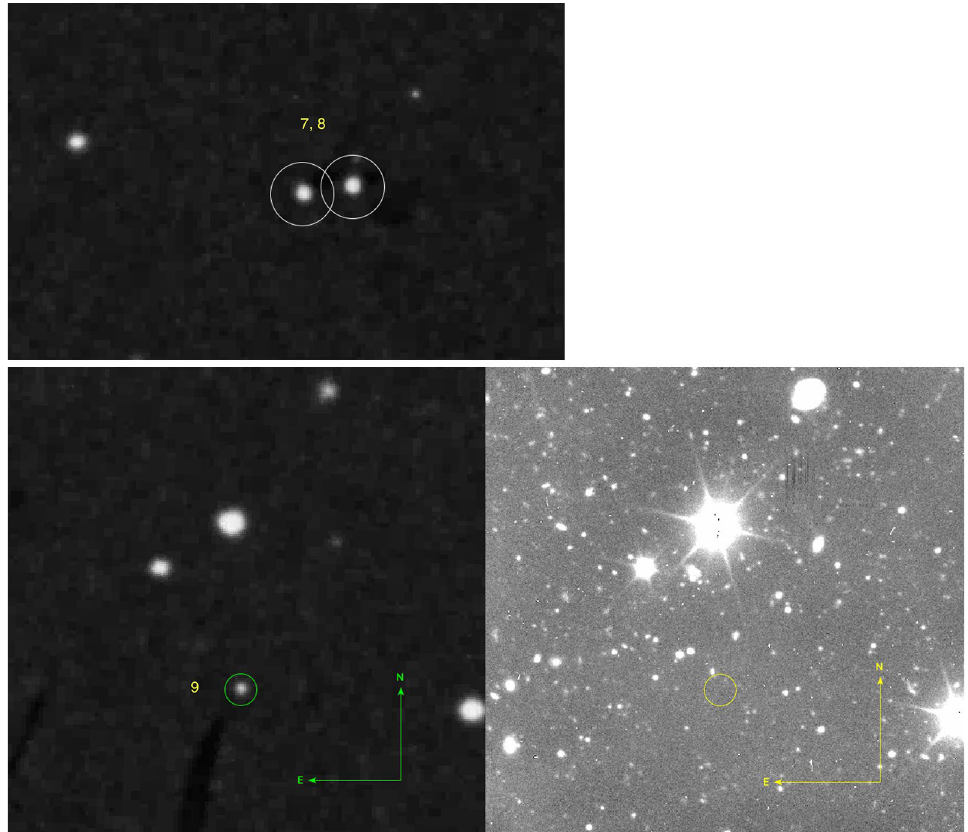
Figure 3. Transients number 7 − 9 . Upper row: we see transients 7 and 8 in POSS-I (marked with 10 arcsec circles), that are not covered by the GTC observations. Lower row: the left image shows the POSS-I red image and the right image shows the GTC/OSIRIS g image. The transients are marked with circles with a radius of 5 arcseconds. The number of counterparts is 1 for transient 9. The POSS-I are based on the high-resolution SuperCosmos digitizations of the Palomar